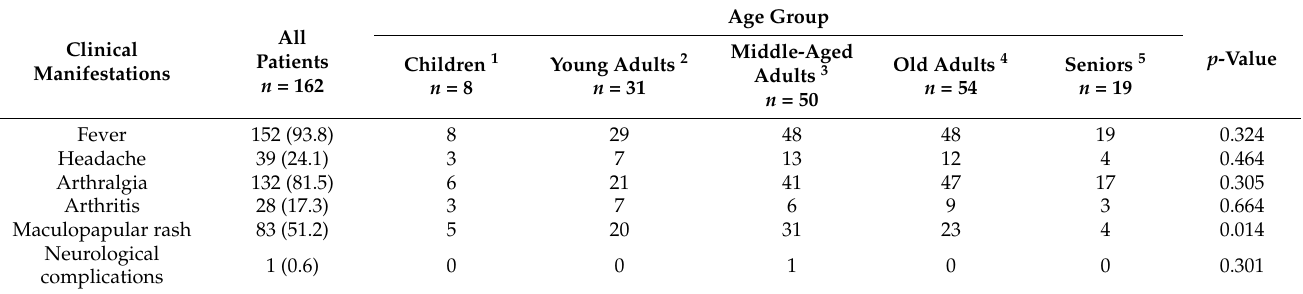
Table 4. Clinical features observed in different age groups of CHIKV-infected patients (N =